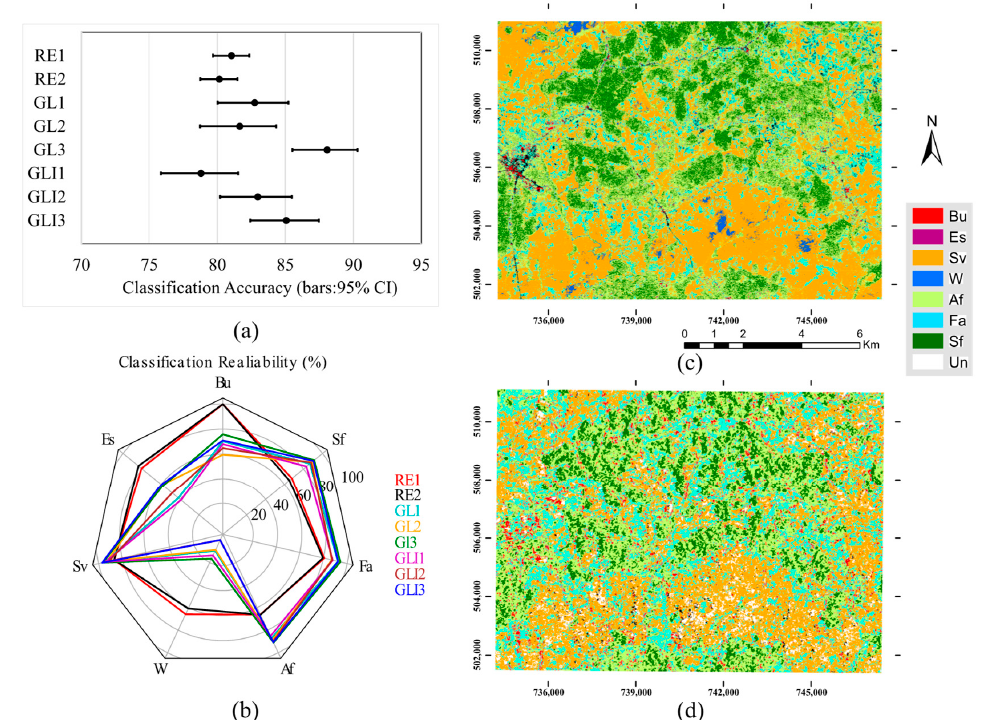
Figure 6. The pixel-based classification result for the eight models evaluated by the random forest ensemble algorithm: ( a ) classification accuracy; ( b ) class reliability estimates; ( c ) the thematic land cover / land use map for the RE1 model; and ( d ) the thematic map for the GL3 model. The scale bar, legend, and north arrow apply to both ( c , d ).